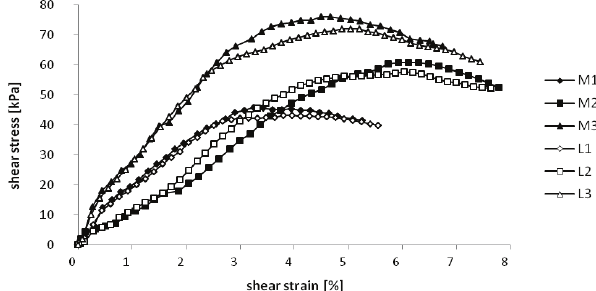
Fig. 3. Results of direct shear test in medium and large box for sample preparation with 2% water content